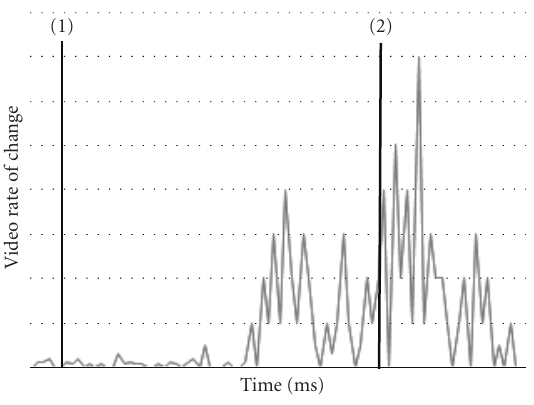
Figure 2: Video rate of change versus